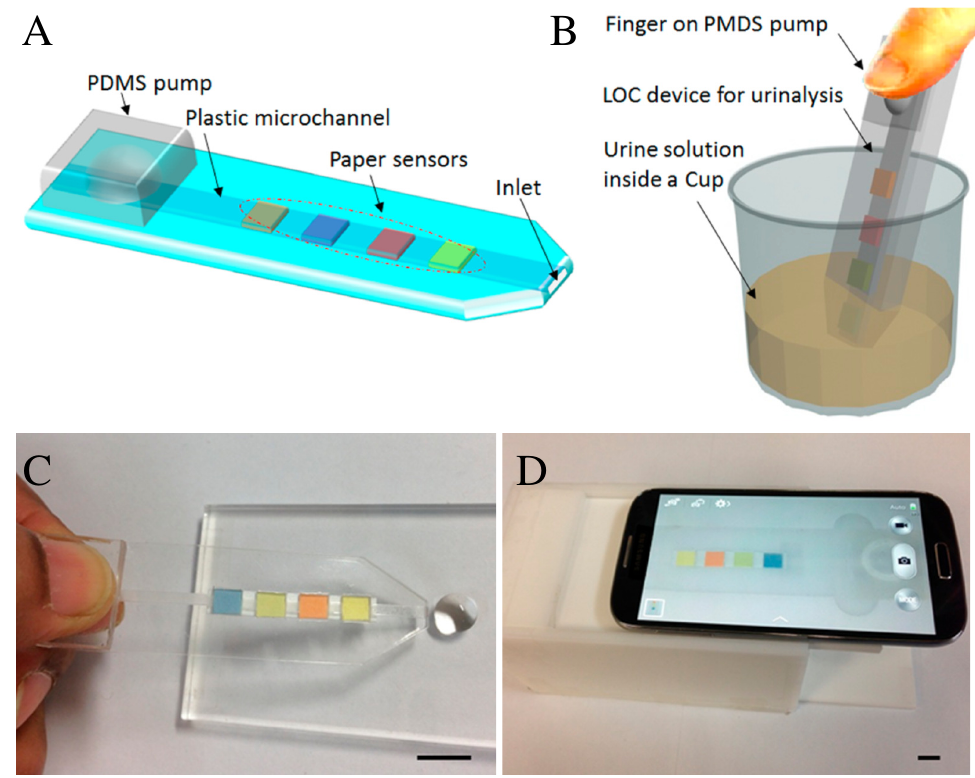
Figure 2. ( A ) Schematics of the hybrid point-of-care (PoC) microfluidic device. ( B , C ) The manual insertion (by finger pressing the pump) of the analyte into the reagent chambers from a sample container (a cup) or a drop. ( D ) A smartphone-based optical platform for colorimetric analysis. Reproduced with permission from Ref. [63]. Copyright 2017 American Chemical